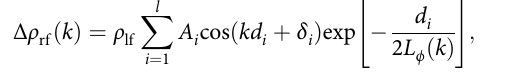
Fig. 3a): the quadrilateral path corresponds to the electron states scattered sequentially by the corral, adatom at the left focus and corral again, then back to the right focus. Therefore, the length of the path can be obtained as: d The phase shifts can be obtained as δ δ